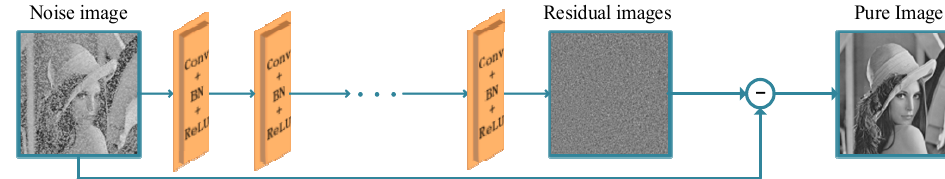
Figure 10. Structure of a deep residual network. After the predicted noisy images are fed into the network as a dataset for training, the real noisy images are used in the tests . The PSNR and SSIM were able to reach 35.472 and 0.971 respectively. The denoised visual results are shown in Figure 11.